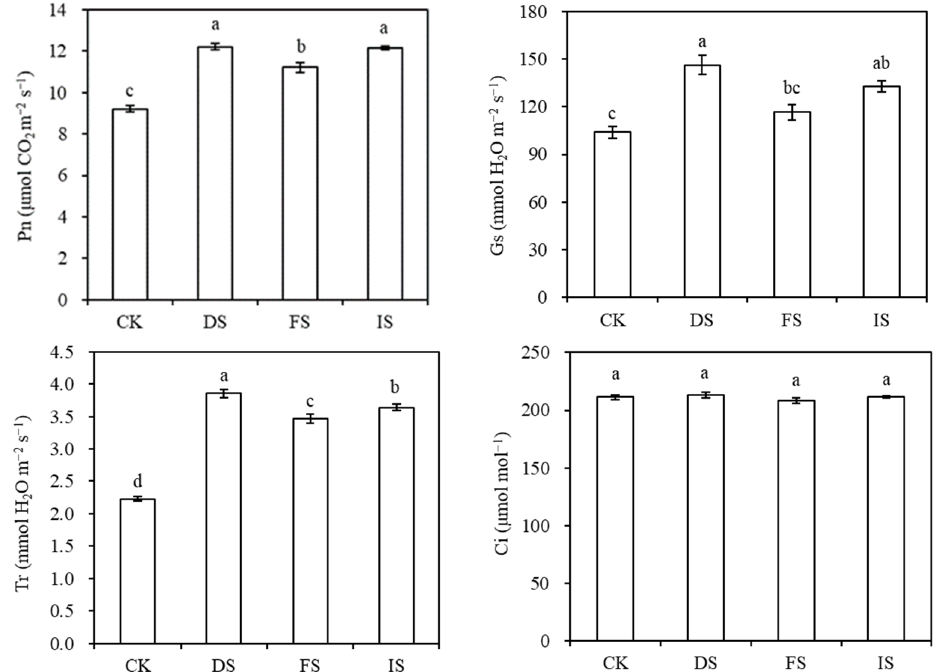
Figure 1. Effects of different forms of Tagetes erecta biofumigation on net photosynthetic rate (Pn), Intercellular CO 2 concentration (Ci), stomatal conductance (Gs) and transpiration rate (Tr) of M. hupehensis leaves. CK: replanted soil, DS: air-dried T . erecta sample, FS: fresh T . erecta sample, IS: infusion solution of fresh T . erecta . Data are the means of three replicates, and the different letters over on the columns indicate significant differences at p < 0.05.